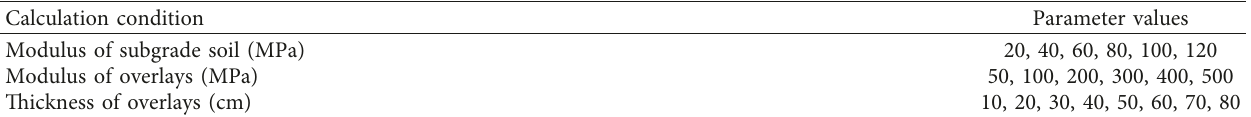
Table 3: Calculation conditions under different modulus values of subgrade soil and modulus values and thicknesses of overlays. Calculation condition